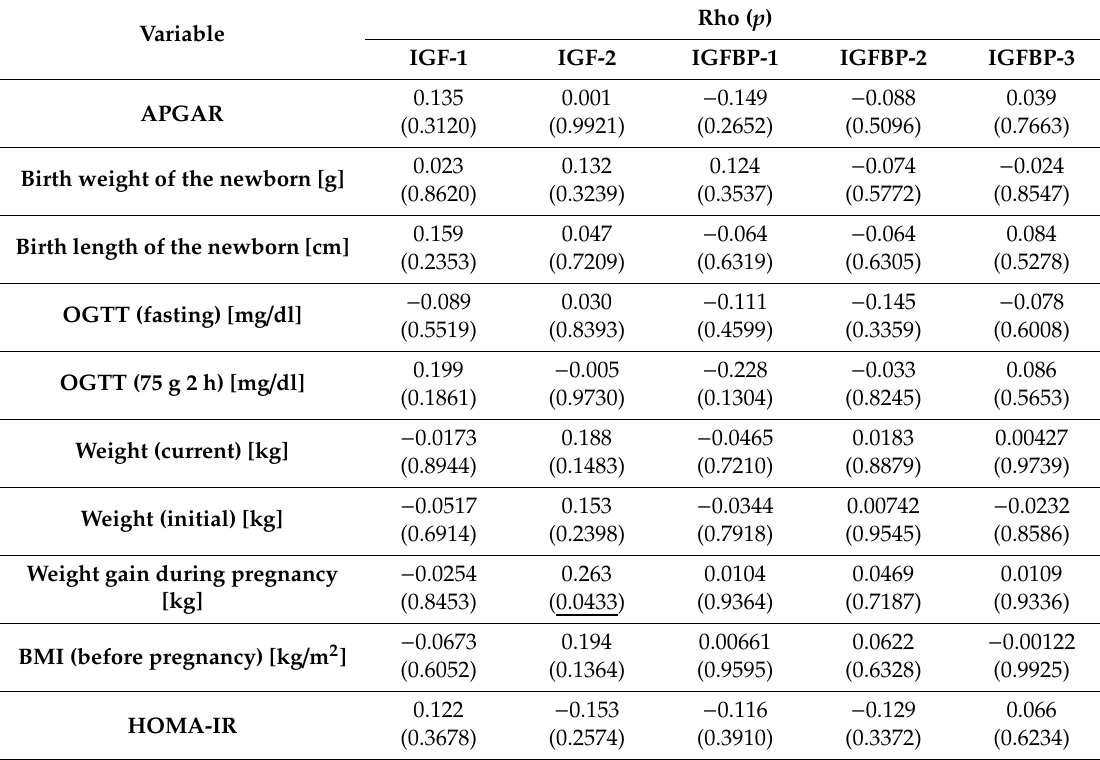
Table 3. Spearman’s correlation between maternal plasma (IGF-1, IGF-2, IGFBP-1, IGFBP-2, IGFBP-3) concentrations (ng / mL) and clinical / biochemical parameters in the GDM group.